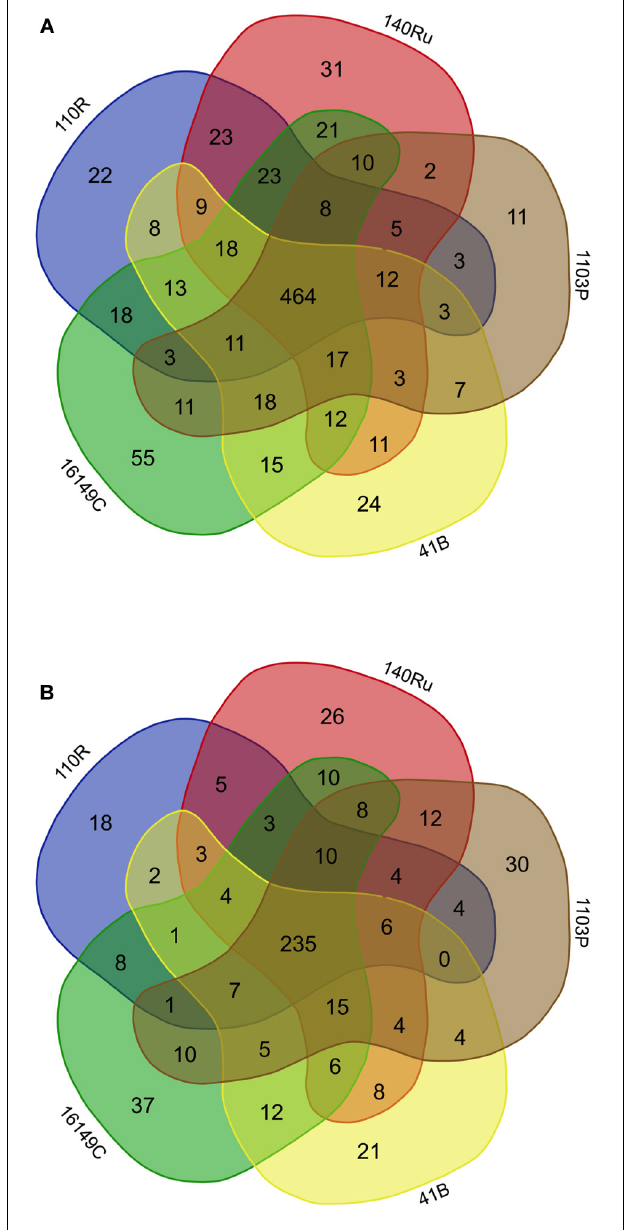
FIGURE 6 | Venn diagrams showing the common and exclusive bacterial (A) and fungal (B) OTUs of the rhizosphere of the grapevine rootstocks in Olite